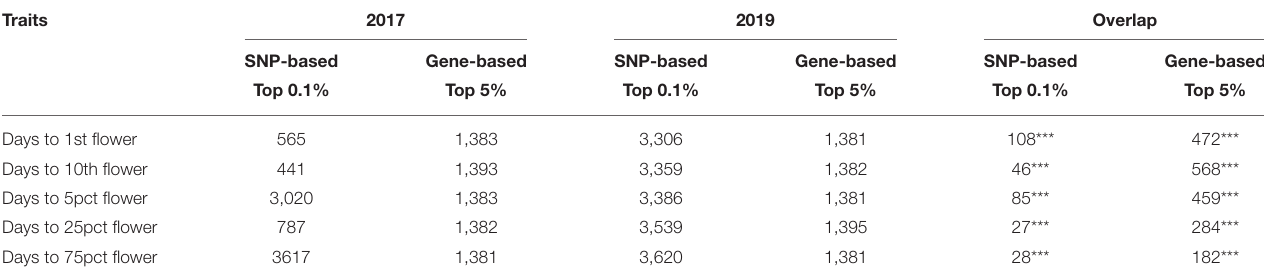
TABLE 1 | The number of associated single nucleotide polymorphisms (SNPs) and candidate genes identified from marker- and gene-based association tests and their overlap between 2017 and 2019. Traits